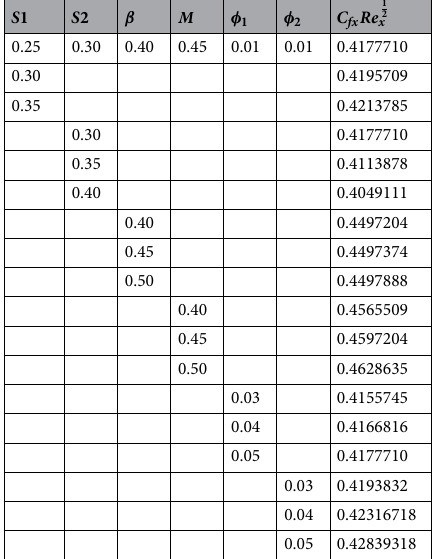
Table 2. Outcome of different physical factors over Skin friction C fx Re